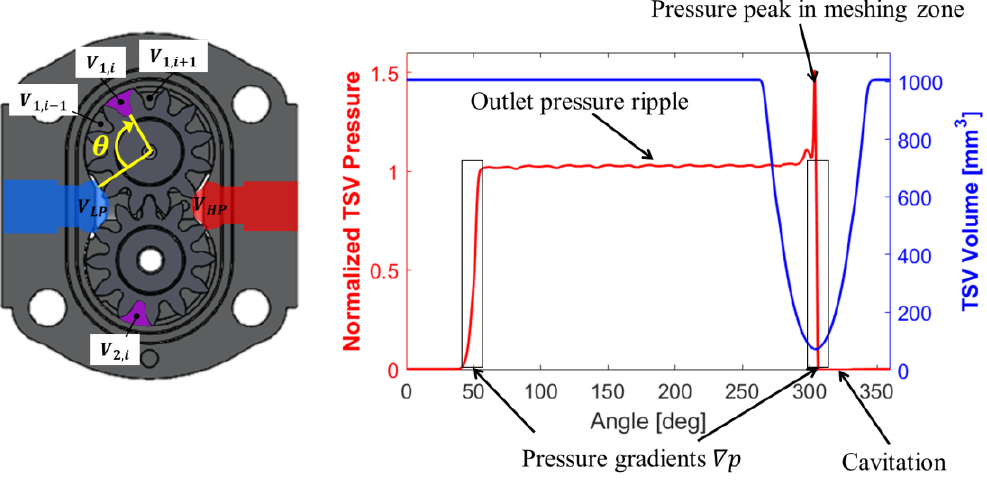
Figure 6. Instantaneous volume of a tooth space chamber (TSV) (blue) and TSV pressure (red) obtained from HYGESim. On the left, the angular convention, where θ defines the TSV position with respect to the start of the internal casing